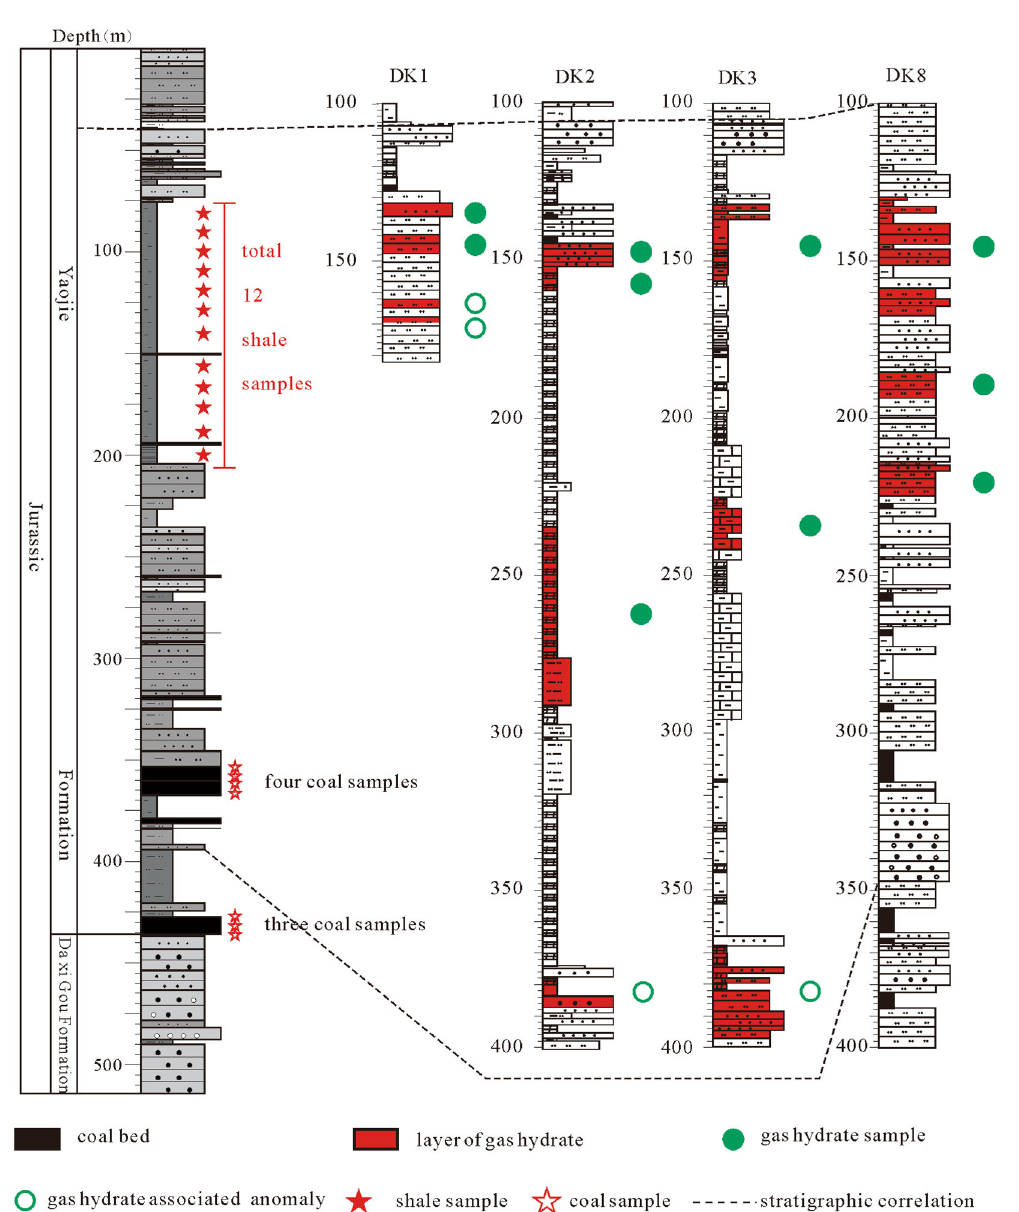
Fig. 2 Stratigraphic column showing the sampling layer and gas hydrates distribution in the Yaojie formation form the Juhugeng Sag (Modified from Tan et al.